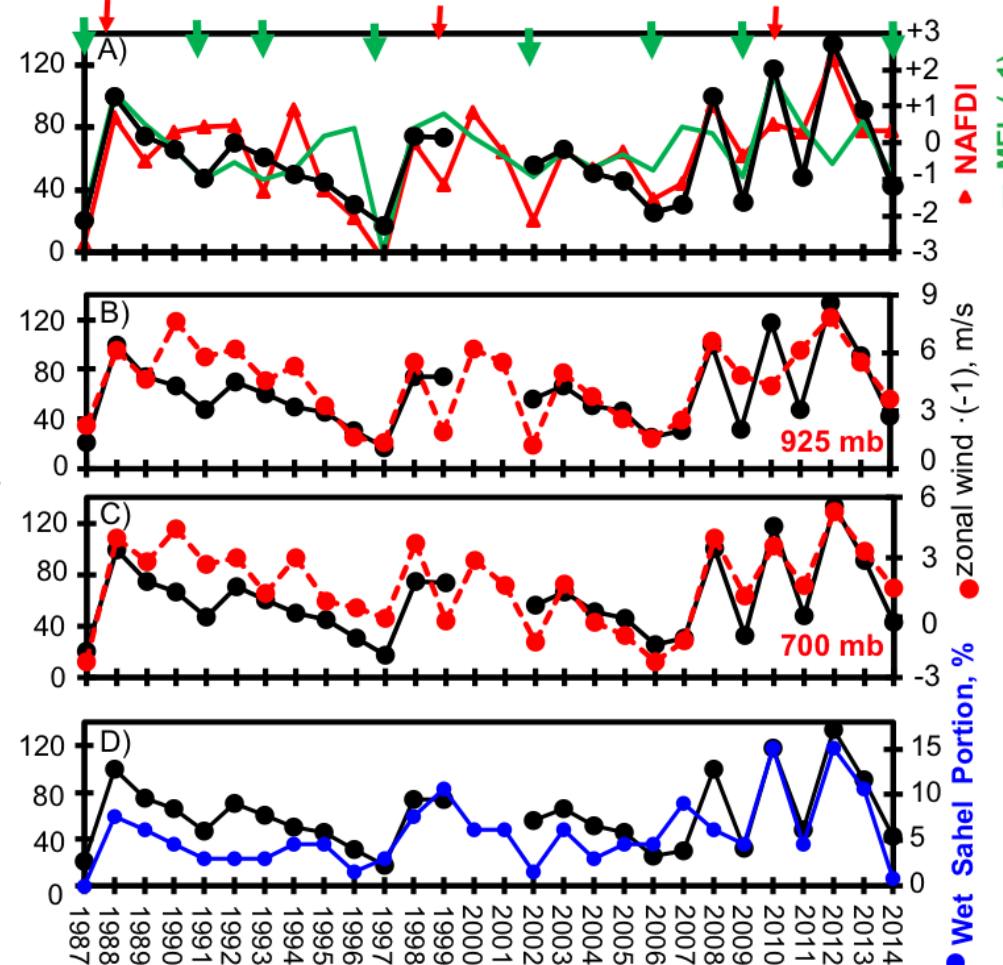
Figure 3. Long-term evolution (1987–2014) of summer dust and meteorology. Summer mean values of dust T concentrations at Izaña (black dot, (a–d) , MEI (green line, a ), NAFDI (red triangle, a ), zonal wind at 925mb in the subtropical Saharan Stripe (25–28 ◦ N, 7 ◦ W–2 ◦ E, b ), zonal wind at 700mb averaged in the subtropical Saharan Stripe to Tenerife corridor (25–28 ◦ N, 16 ◦ W–2 ◦ E, c ) and the Wet Sahel Portion (blue dot) from 1987 to 2014. Green and red arrows highlight moderate and intense ENSO and La Niña summers, respectively